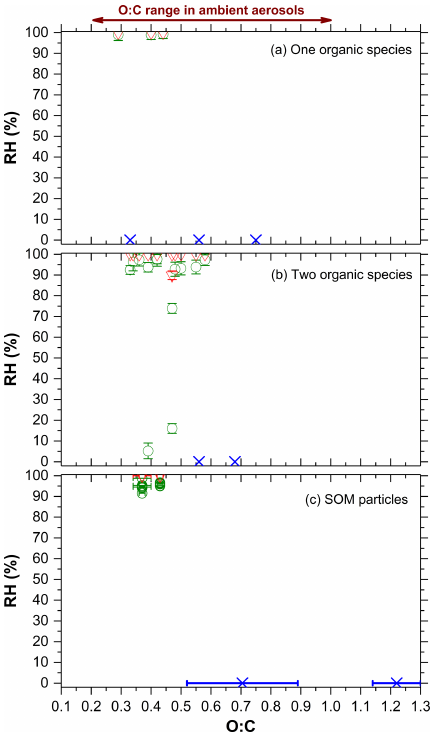
Figure 5. Lower and upper RH boundary for LLPS as a function of the O:C of the organic particle: (a) particles containing one organic species, (b) particles containing two organic species, and (c) par- ticles consisting of secondary organic material generated in envi- ronmental chambers. Only results for experiments with increasing RH are shown. Green circles represent the lower boundary for the LLPS, and red triangles represent the upper boundary for LLPS. Blue crosses indicate that LLPS was not observed during RH cy- cles. Uncertainties represent 2 σ of multiple measurements and the uncertainty from the calibration. Results for particles consisting of secondary organic material (c) were taken from Renbaum-Wolff et al. (2016), Rastak et al. (2017), and Song et al. (2017). The O:C range of the SOM particles is based on previous studies (Heaton et al., 2007; Lambe et al., 2015; Li et al., 2015; Renbaum-Wolff et al., 2016; Rastak et al., 2017; Song et al., 2017). The arrow at the top of the figure represents the O:C range of organic particles in the atmosphere (Zhang et al., 2007; Hallquist et al., 2009; Jimenez et al., 2009; Heald et al., 2010; Ng et al.,